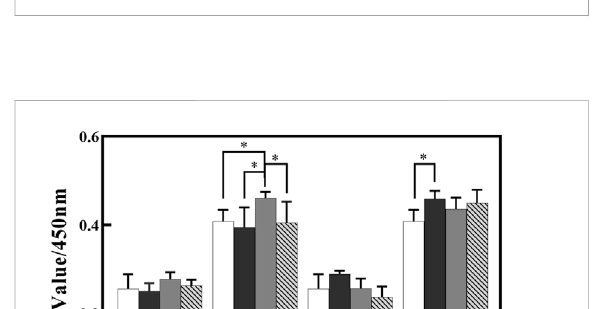
FIGURE 3 Contact angle of samples ( n = 10, NS: No signi fi cant difference).